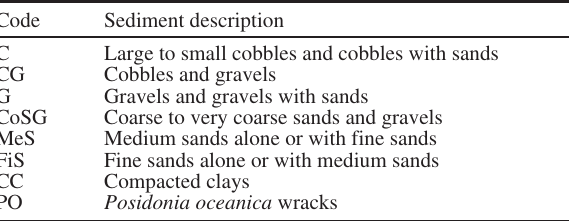
Table 3. – Codes used for the sediment description in the analyses and figures. Only dominant proportions are shown.